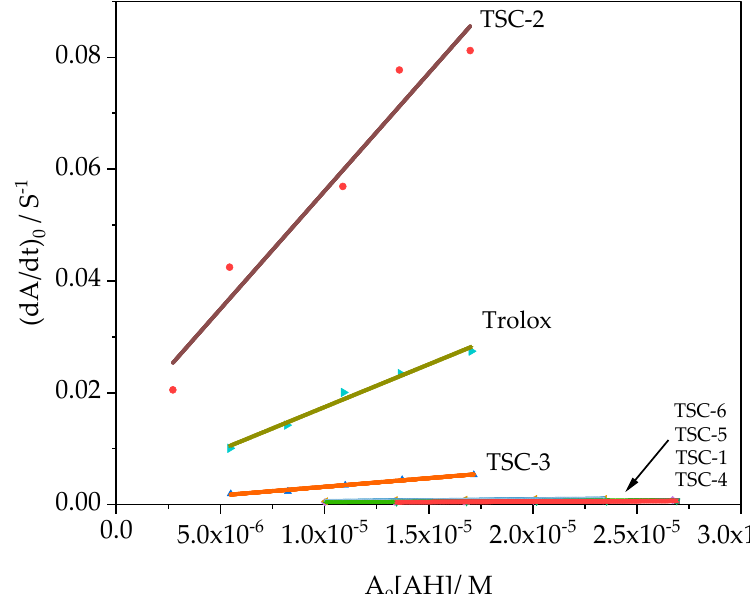
Figure 4. Linear plots of (dA / dt) 0 vs. A 0 [AH] of compounds. A 0 is the absorbance at time = 0, and [AH] is the concentration of antioxidant at time = 0, R 2 > 0.9500.